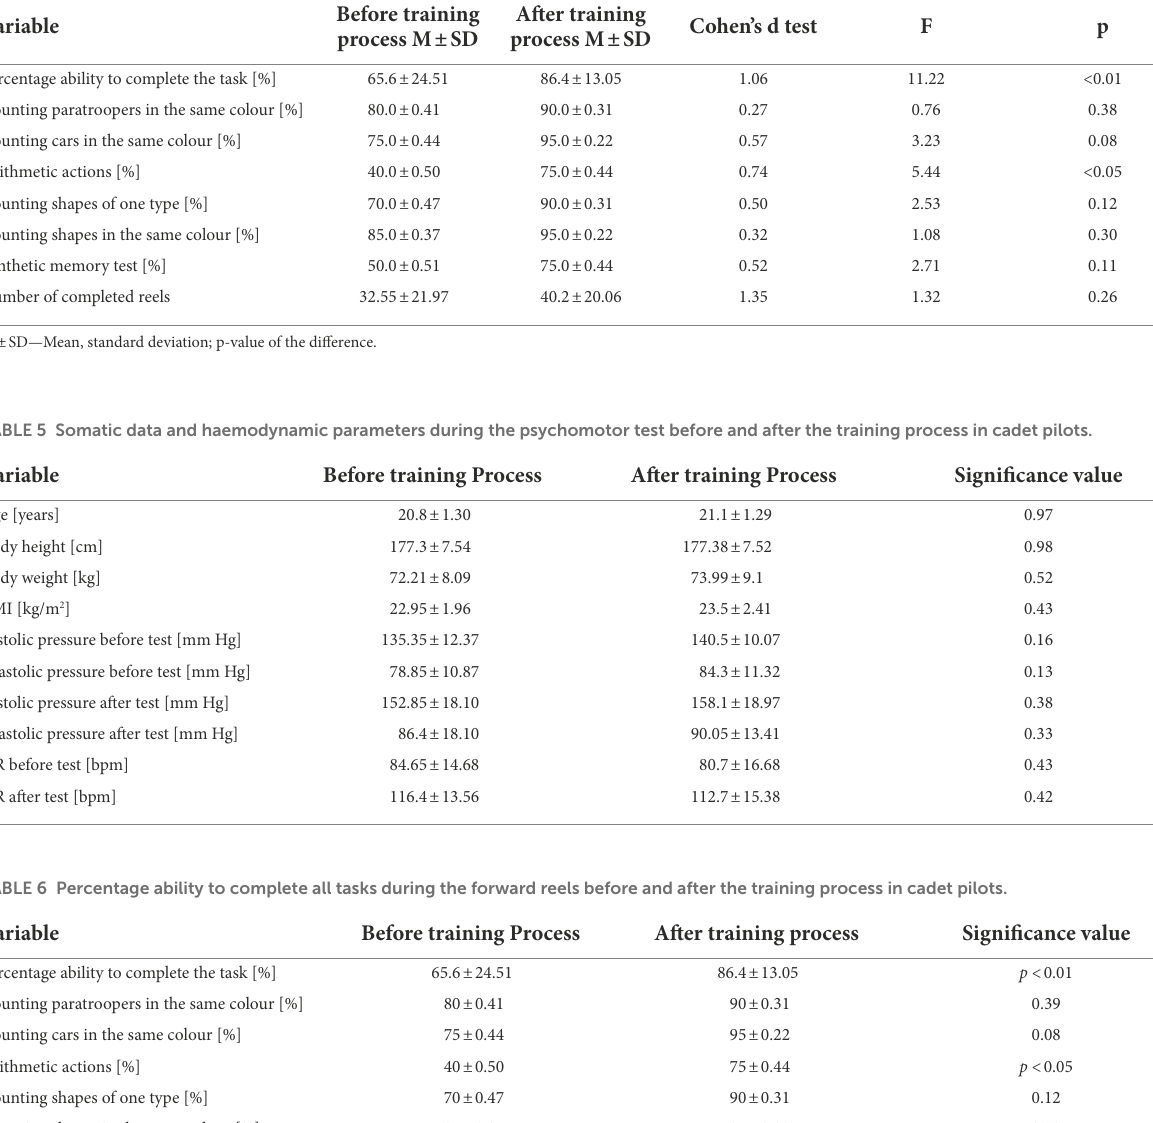
TABLE 4 Difference in individual psychomotor skills before and after the training process in cadets pilots ( n = 20).